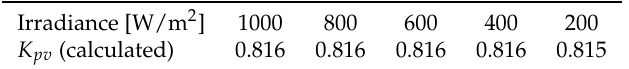
Table 3. The calculated voltage factor for different irradiance